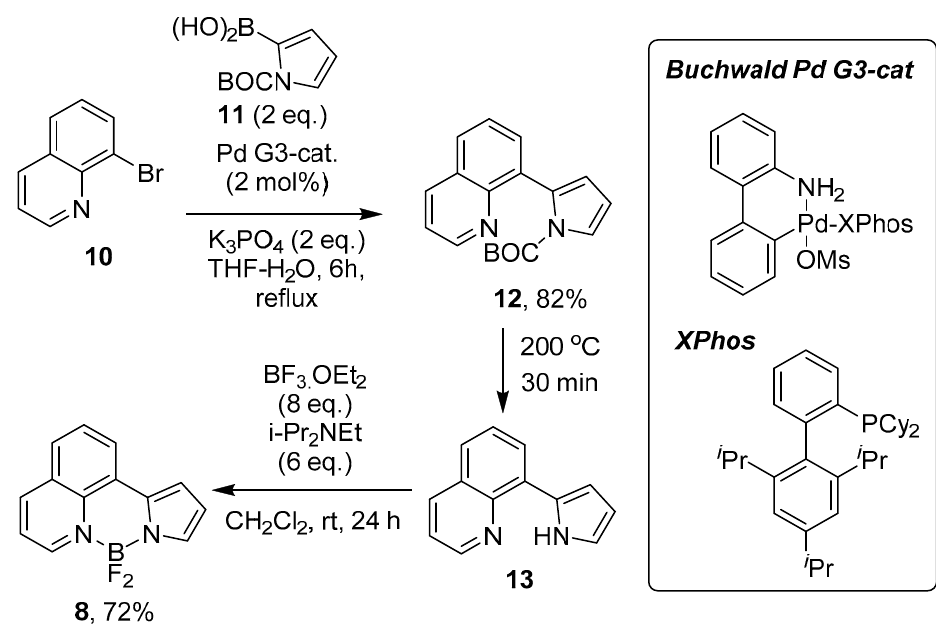
Scheme 1. Synthesis of BF 2 -chelated pyrrolylquinoline 8 .